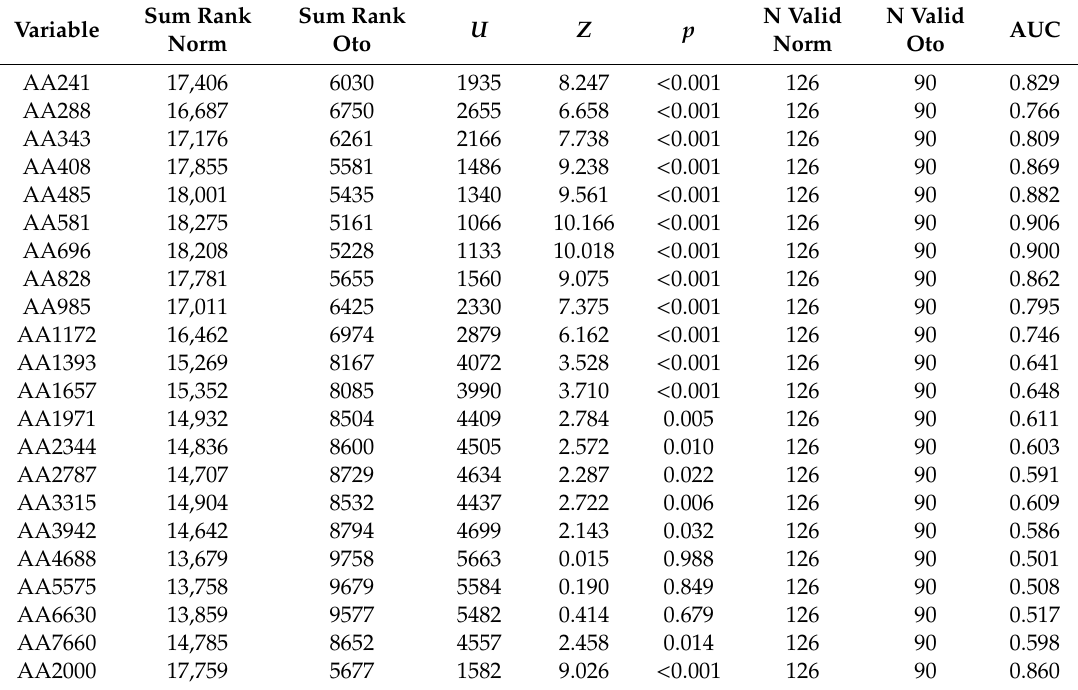
Table 3. Results of Mann–Whitney U-test for comparing absorbance between the Normal and Otosclerotic